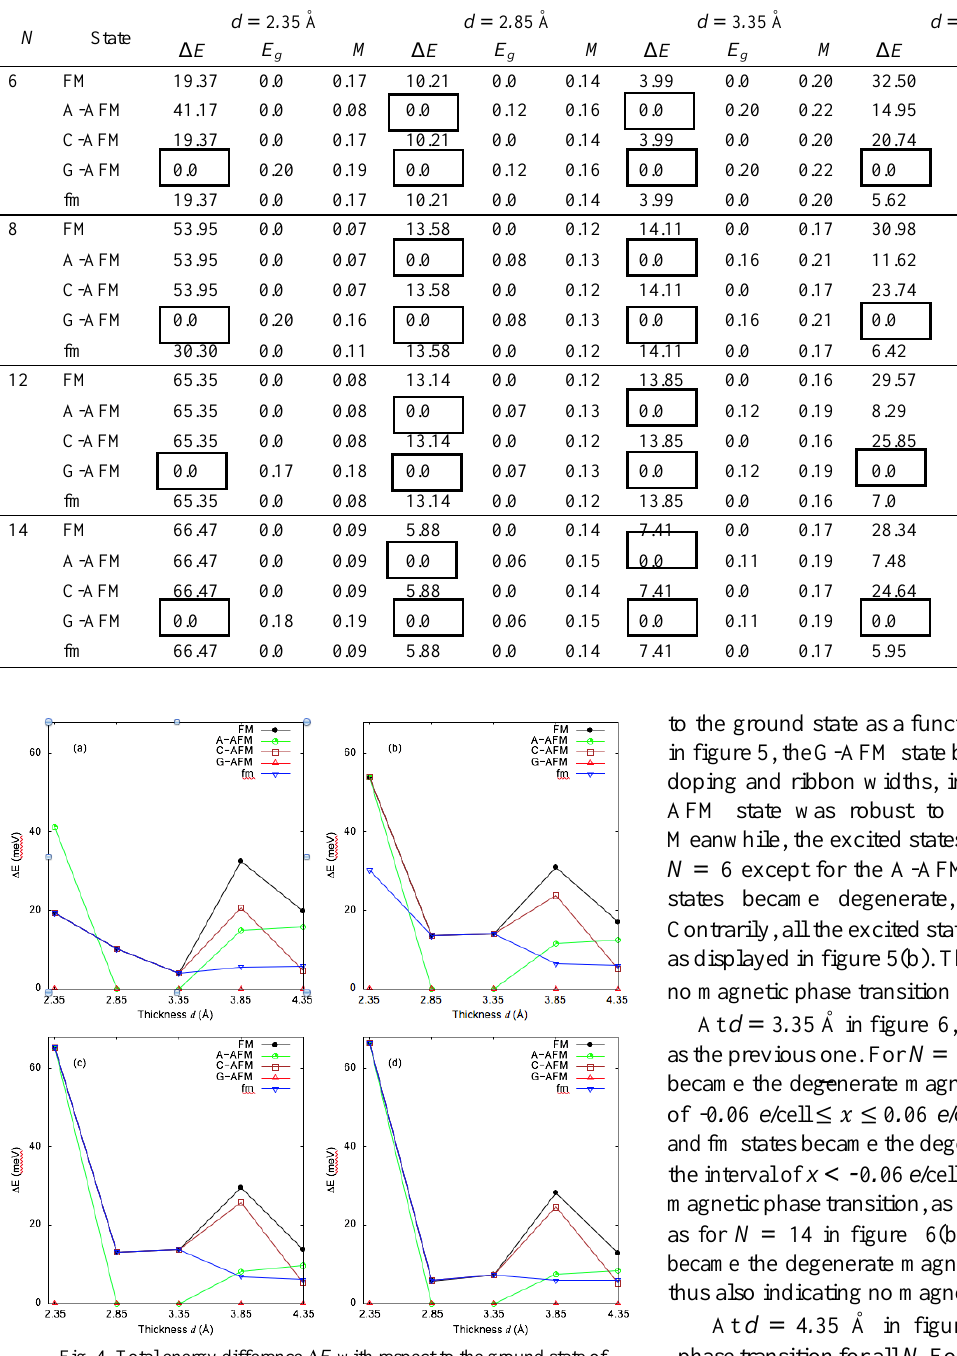
Fig. 4. Total energy difference ∆ E with respect to the ground state of bilayer 6-ZGNR (a), 8-ZGNR (b), 12-ZGNR (c), and 14-ZGNR (d) as a function of thickness